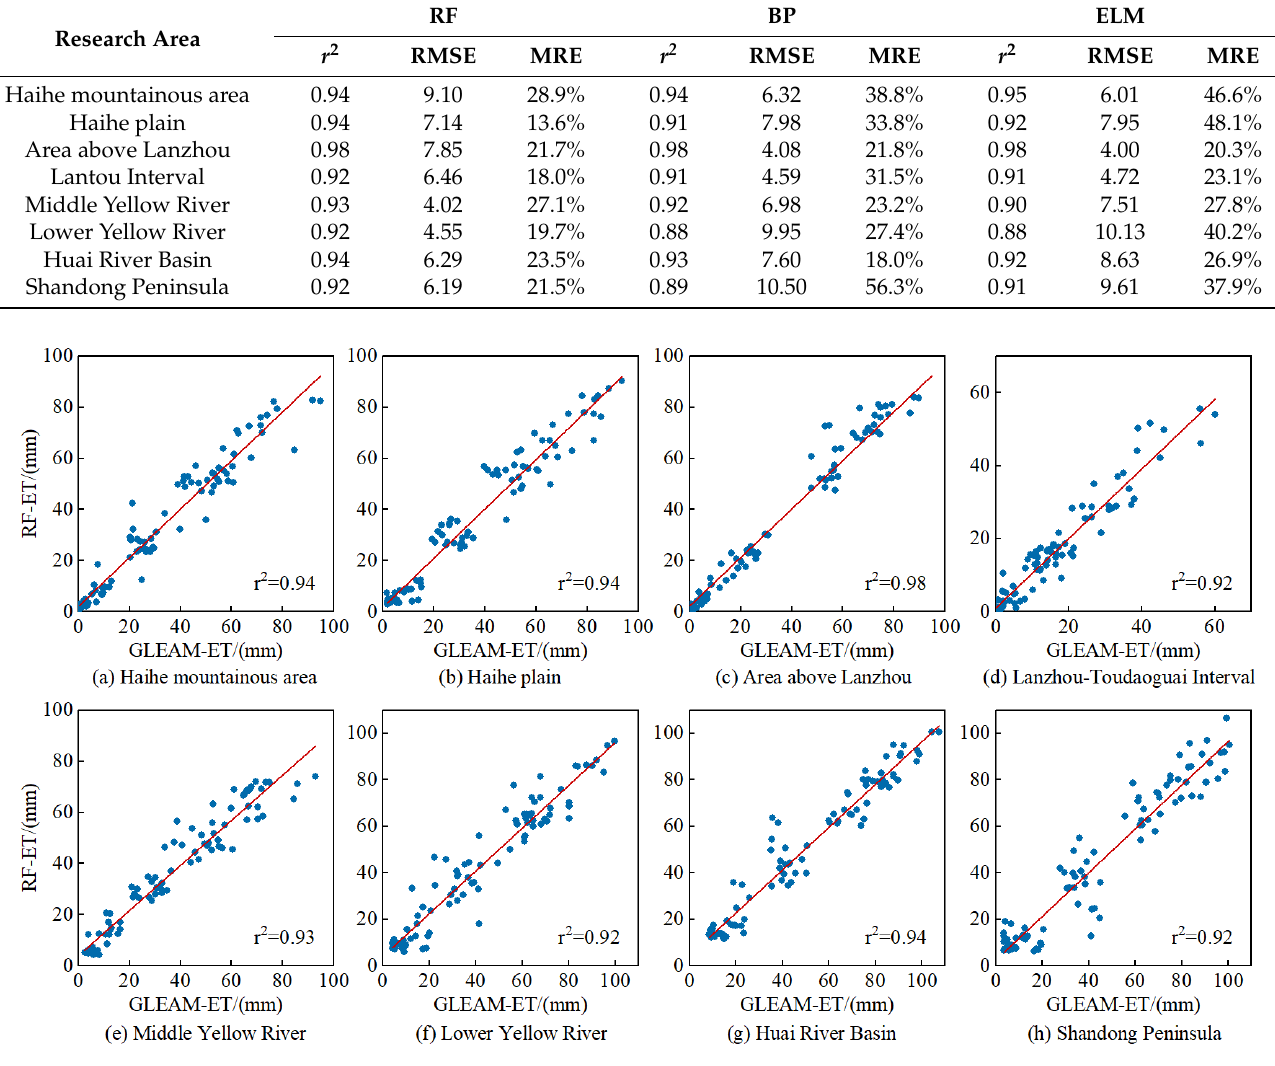
Figure 4. Random forest simulation results.